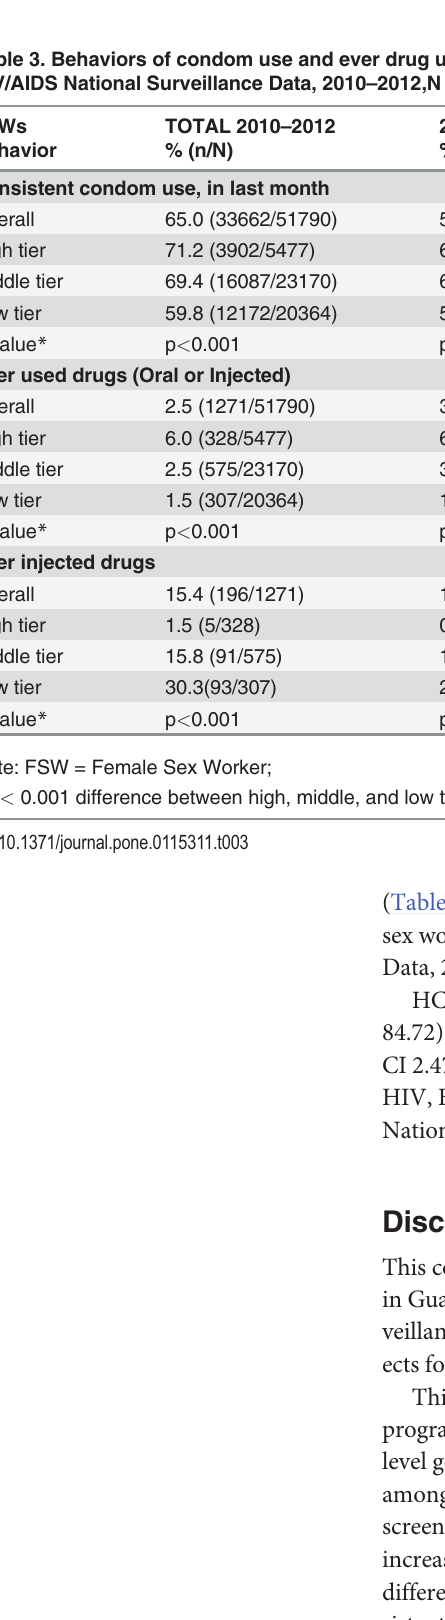
Table 3. Behaviors of condom use and ever drug use among 3 categories of female sex workers (FSWs), Guangxi province, China; China CDC HIV/AIDS National Surveillance Data, 2010 – 2012,N =